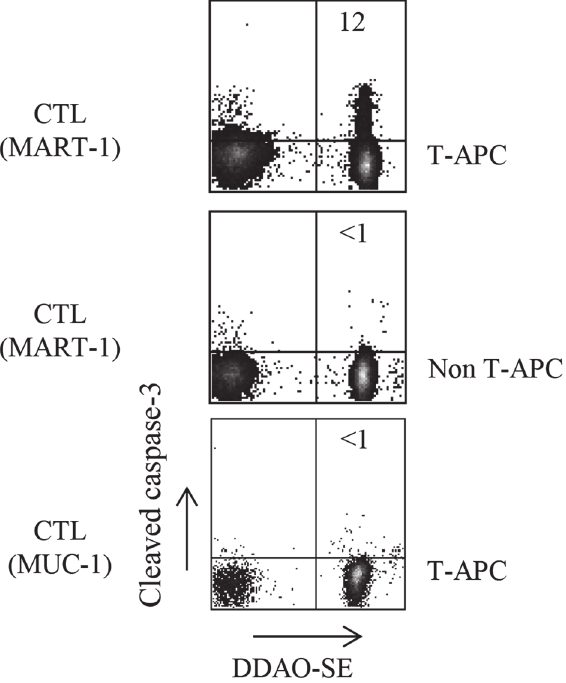
Fig 5. Assessment of CTL fratricide activity based on detection of cleaved caspase-3. MART-1- or MUC-1- reactive CTLs were co-cultured with DDAO-SE-tagged CD8 + T-APCs and non T-APCs, generated by co-incubation of 2E2 cells with 624 mel and M171 melanoma cells, respectively. T-APC damage was examined based on detection of intracellular cleaved caspase-3 in the DDAO-SE + CD8 + population. Numbers in upper right quadrants indicate the percentage of cleaved caspase 3-positive CD8 + T-APC cells. Data are representative of three independent